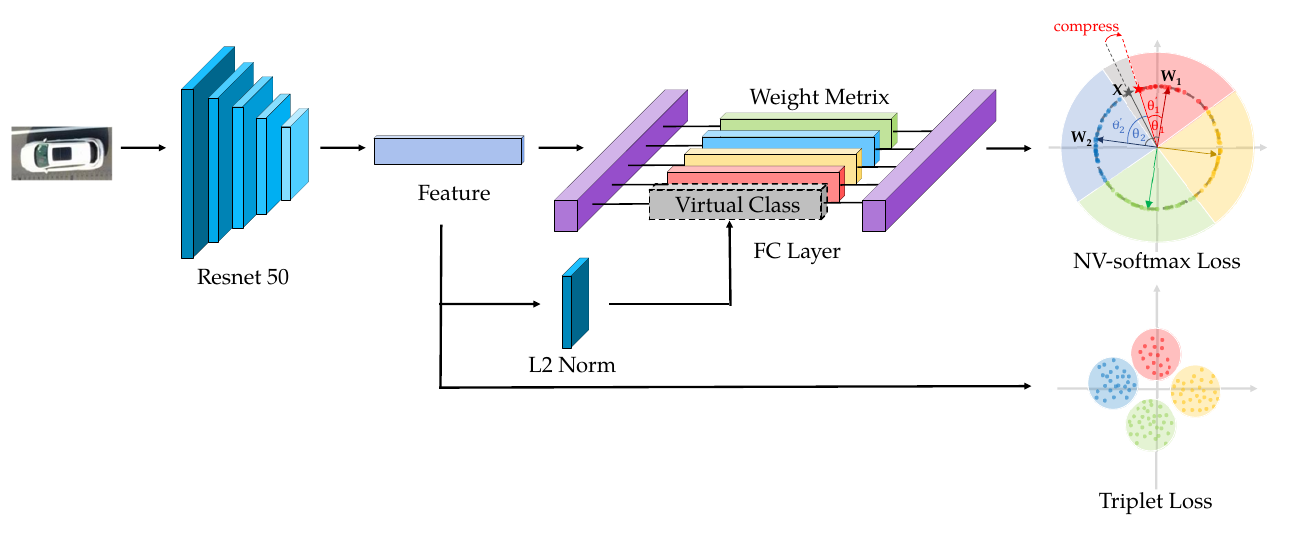
Figure 13. The pipeline of our